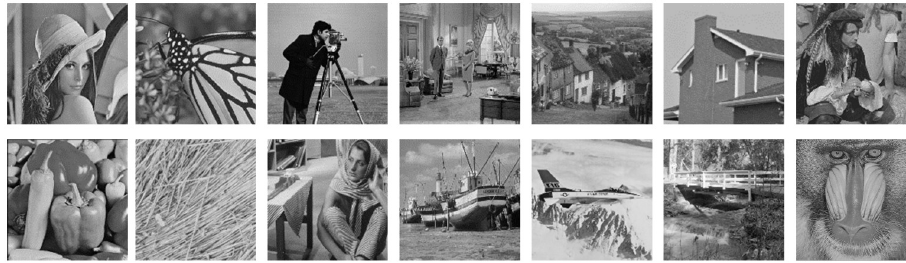
Fig 1. The 14 test images for image